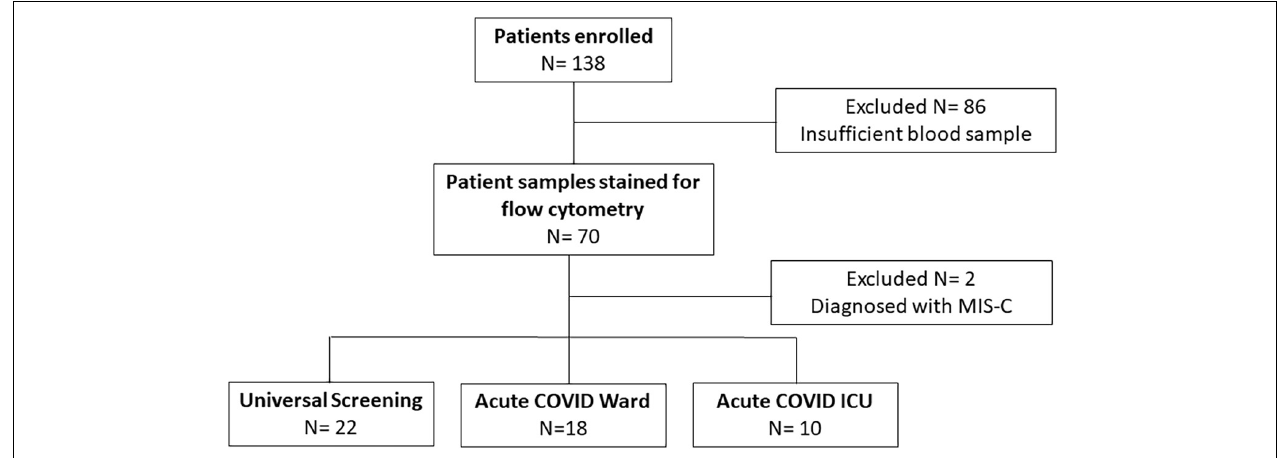
FIGURE 1 | Enrollment flow diagram. This flow chart diagrams enrollment, reasons for exclusion, and final numbers for three comparison groups.